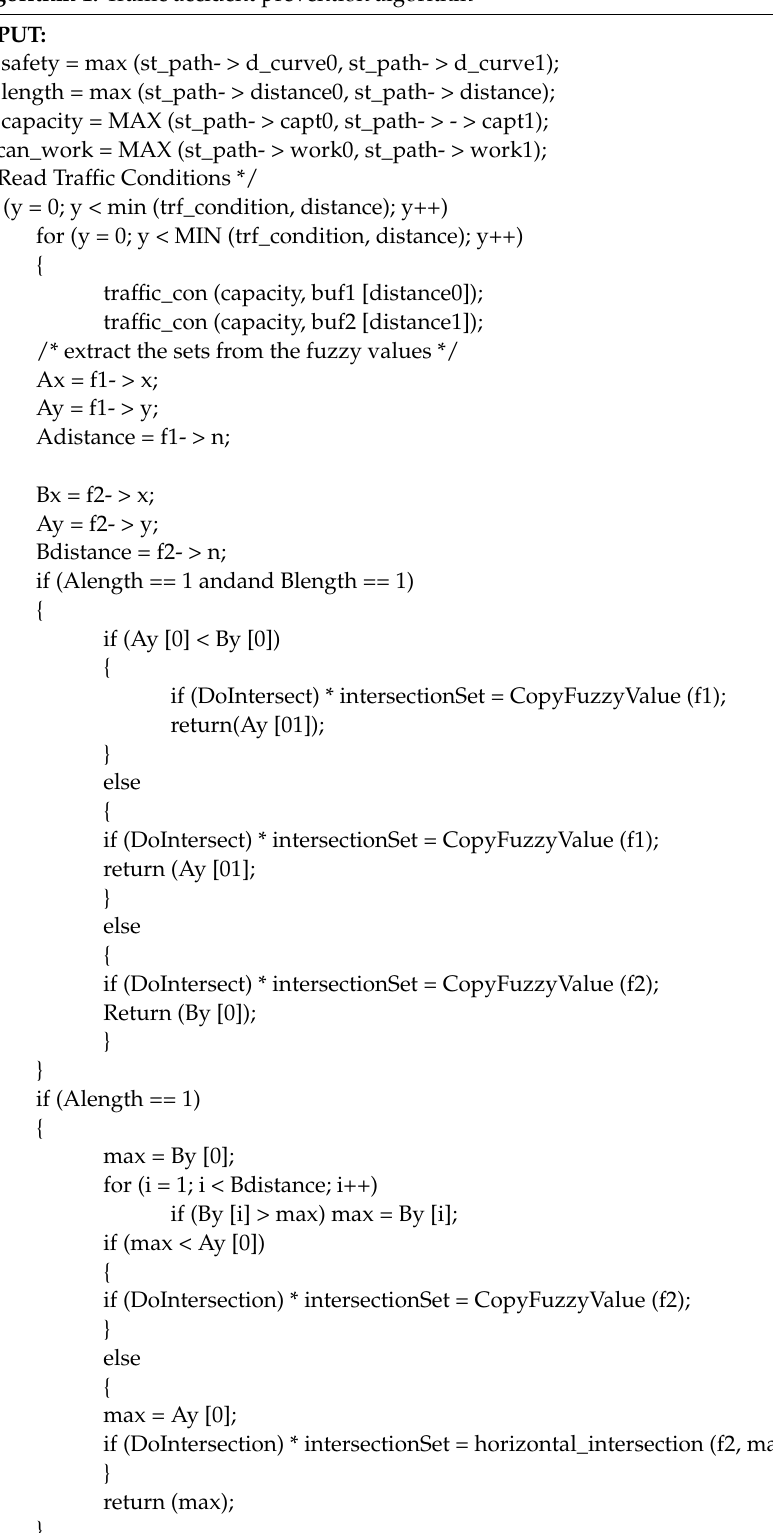
Algorithm 1: Traffic accident prevention